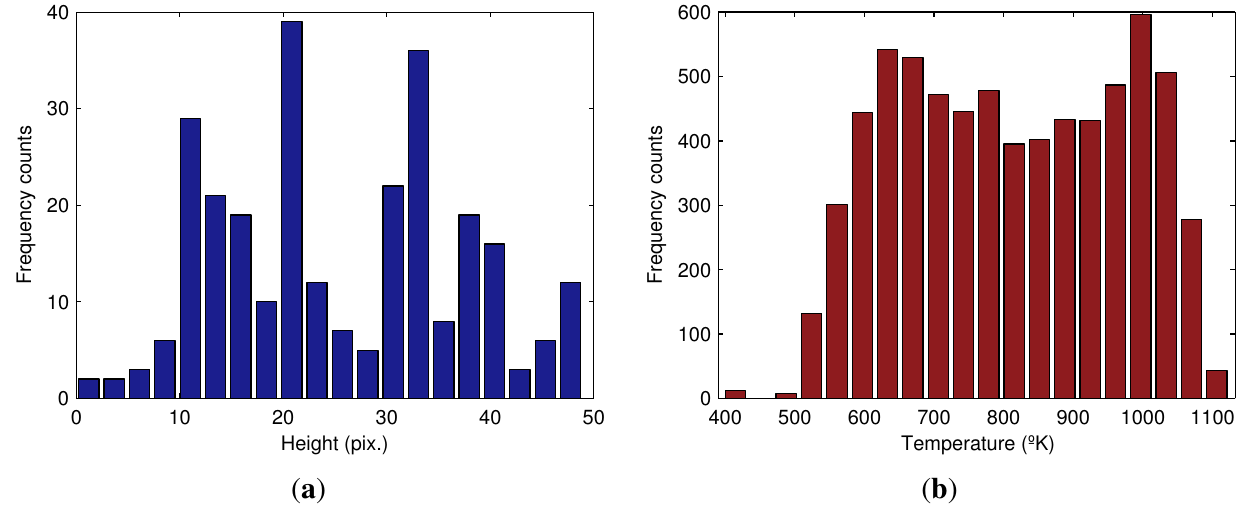
Figure 13. Histograms for the flame front zone. ( a ) Histogram of the heights in the flame front; ( b ) histogram of the temperature values in the flame